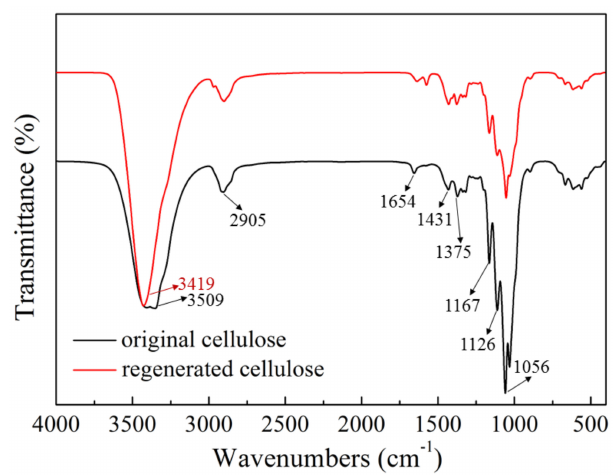
Figure 6. Fourier transform infrared spectroscopy (FT-IR) spectra of the original cellulose, and the cellulose regenerated from the developed [AAeim][OAc]/DMSO co-solvent system.